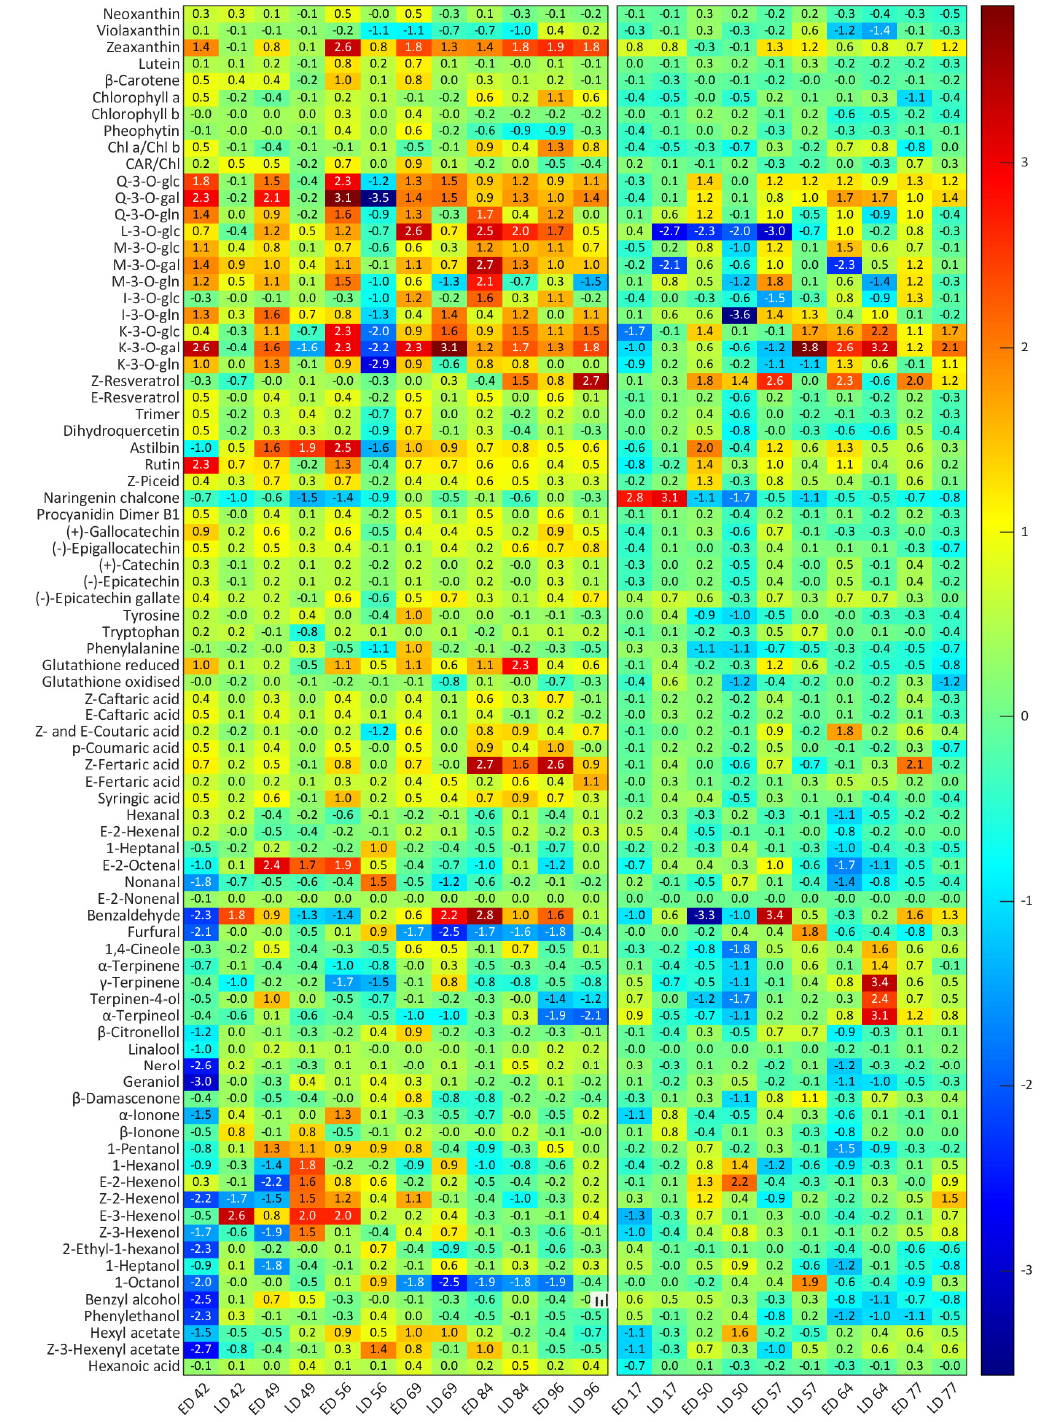
Figure 3. Impact of defoliation timing on carotenoids, polyphenols and free volatile compounds during development at both vineyards. Heatmaps represent log 2 fold change (ED/ND and LD/ND) at each developmental stage. Blue and red colours indicate lower and higher metabolite concentra- tion in ED and LD samples, respectively. BAL (left) and CUM (right). ND, no defoliation; ED, early defoliation; LD, late defoliation; Q, quercetin; L, laricitrin; I, isorhamnetin; K, kaempferol; M, myri- cetin; Glu, glucoside; Gal, galactoside; Gln, gluconoride. Early and late defoliation treatments were conducted at BAL at 9 and 56 DAF, respectively, and at 17 and 50 DAF at CUM.